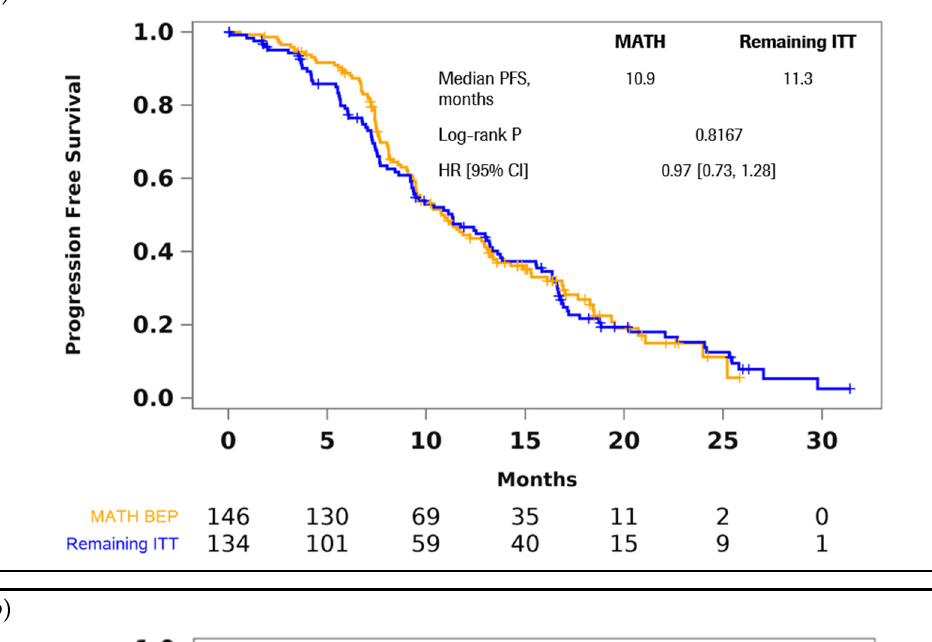
Figure A1. Sample selection for MATH analysis.